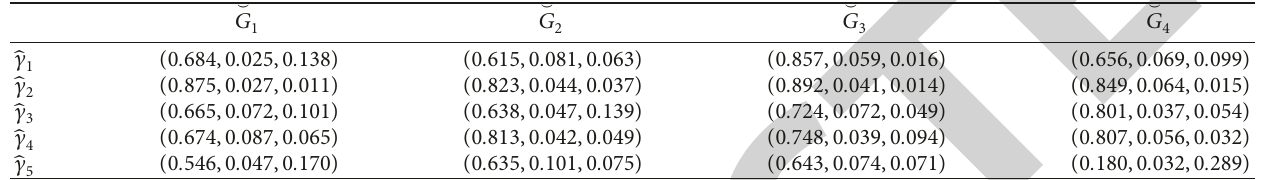
Table 4: Aggregated values of experts by using the ST-PFWA operator.